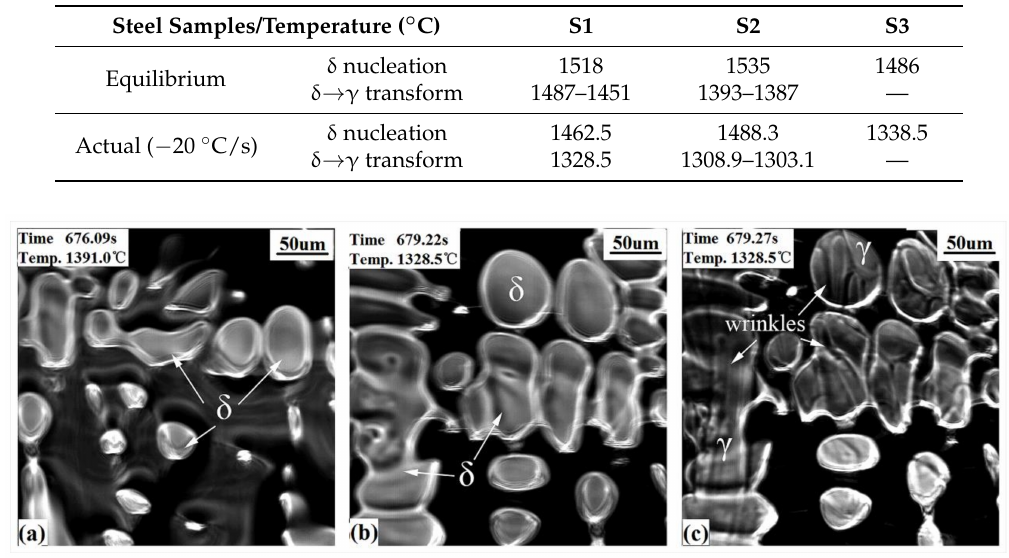
Figure 3. CSLM results of the hypo-peritectic steel (S1) at cooling rate of 20 ◦ C/s. ( a ) δ growth; ( b , c ) before and after δ – γ